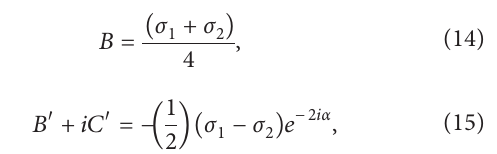
Figure 2: Conformal mapping of the exterior of an unlined tunnel of any shape onto the exterior of a unit